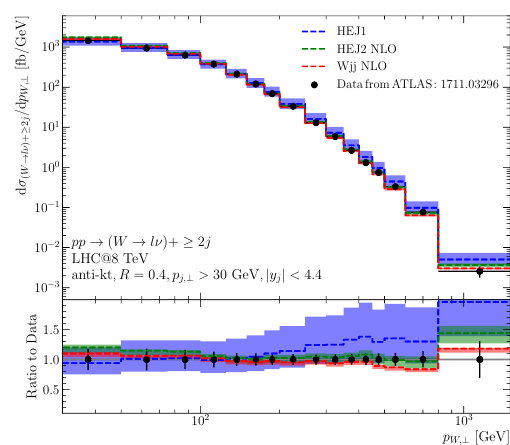
(b) Differential cross section for the transverse mo- mentum of the leading jet.